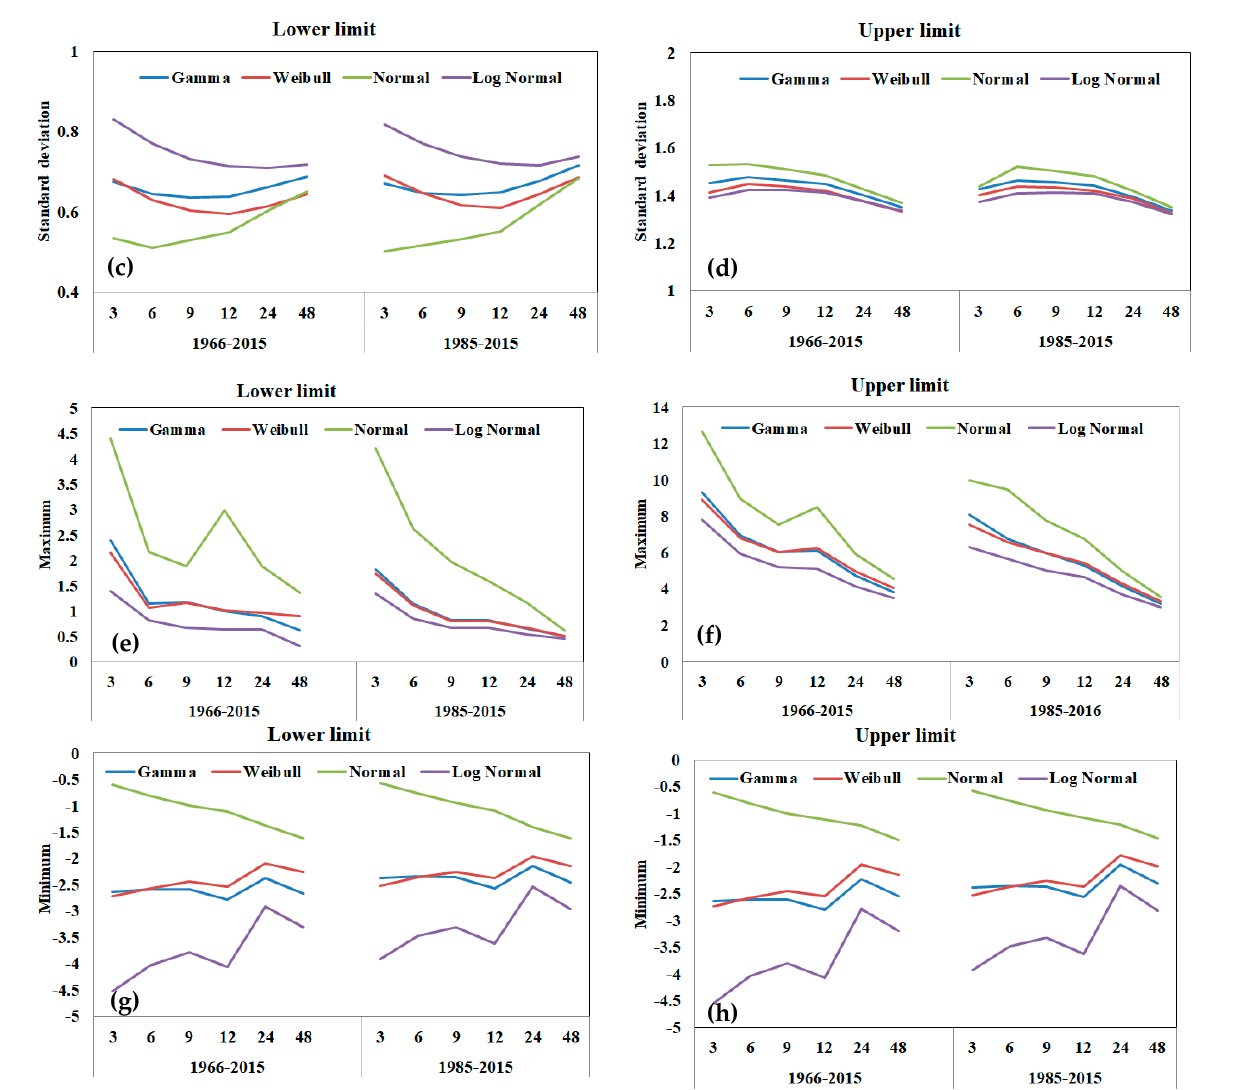
Figure 4. Average values of mean ( a , b ) and standard deviation ( c , d ) of the maximum ( e , f ) and minimum ( g , h ) of the size of the SRI 90% confidence interval, varying the underlying probability distribution and the time scale k on the basis of the data of all stations and the complete time series (1964-65 to 2014-15) and (1986–2015).